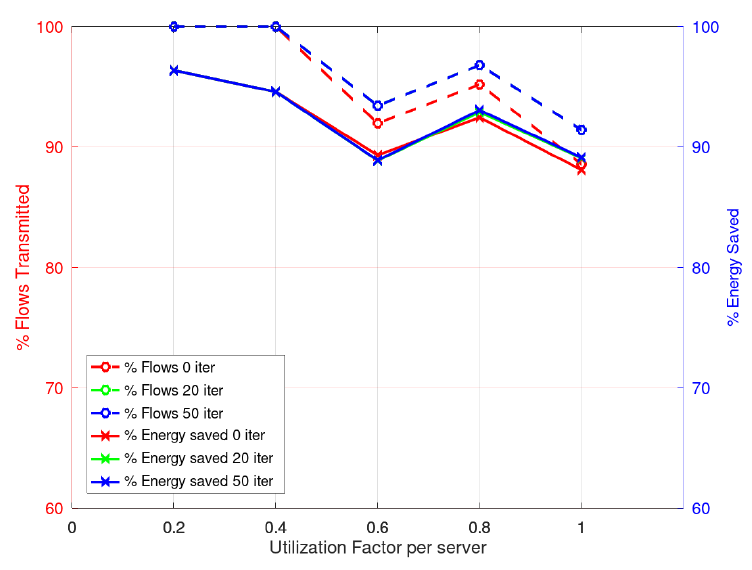
Figure 4. Maximizing the flow scheduling approach.